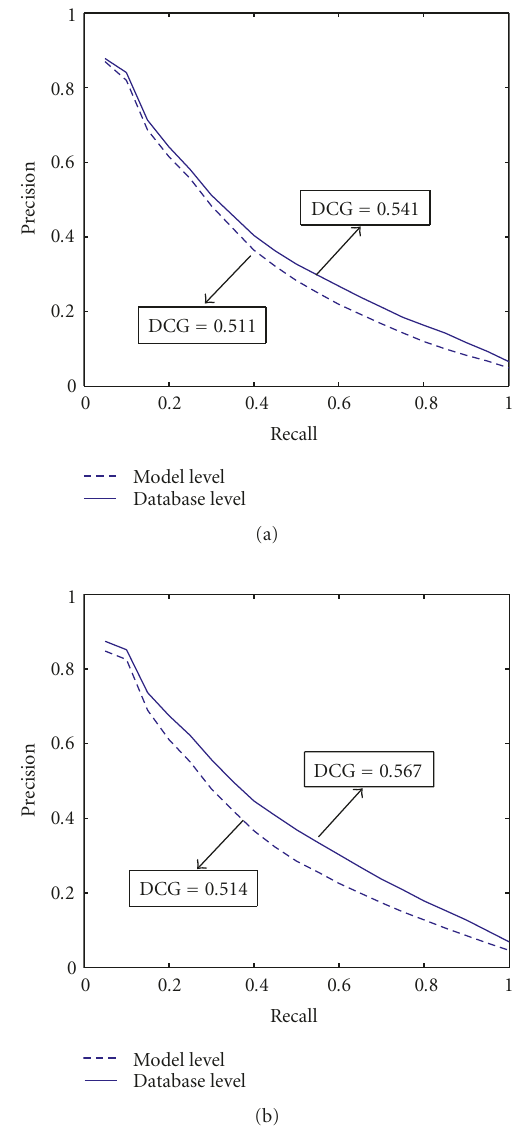
Figure 5: Precision-recall curves with a bandwidth selection made at mesh level versus database level for Sr-descriptor (a) and St- descriptor (b) on PSB training